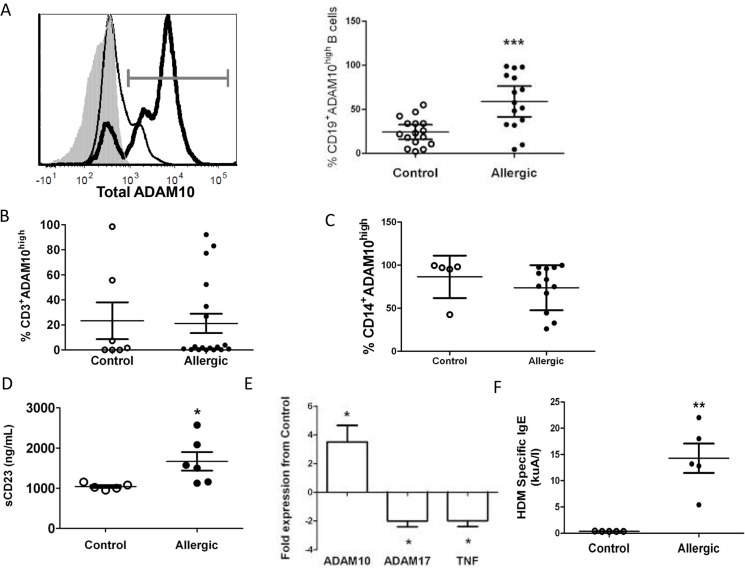
Allergic patient B cells exhibit increased ADAM10 and sCD23 but decreased ADAM17 and TNF.(A) Total ADAM10 in naïve CD19+ B cells from control (thin line, open dot) and allergic (bold line, black dot) patients; dot plot (right) shows percent of total B cells staining high in ADAM10 (grey gate). Isotype control is shaded grey in histogram. (B,C) Total ADAM10 on naïve T cells (B) and monocytes (C). (D) sCD23 from control (open dot) or allergic (black dot) supernatants. (E) Naïve B cells from 4 allergic and 4 control patients analyzed for ADAM10, ADAM17, and TNF message normalized to GAPDH. Significance (*) indicates ≥ 2 fold change between allergic and control B cells for respective gene. (F) HDM specific IgE levels in sera of control (open dot) or allergic (black dot) patients determined by ImmunoCAP. <0.35kuA/l considered a negative result. *p<0.05, **p<0.005, ***p<0.0005.